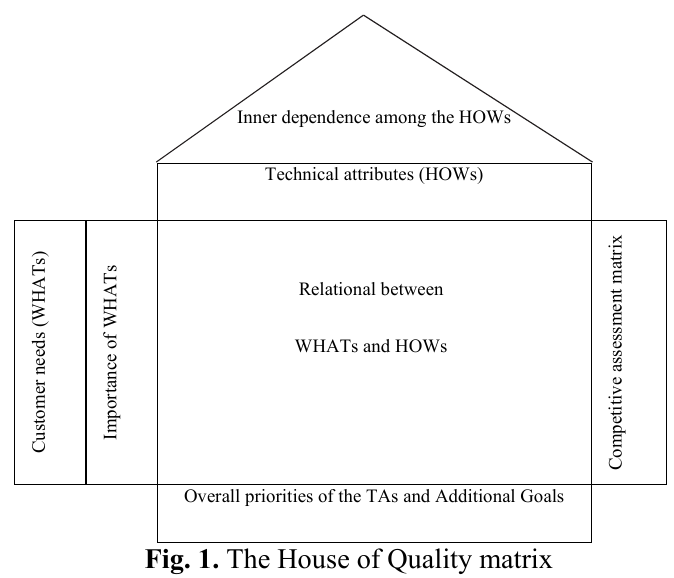
Fig. 1. The House of Quality